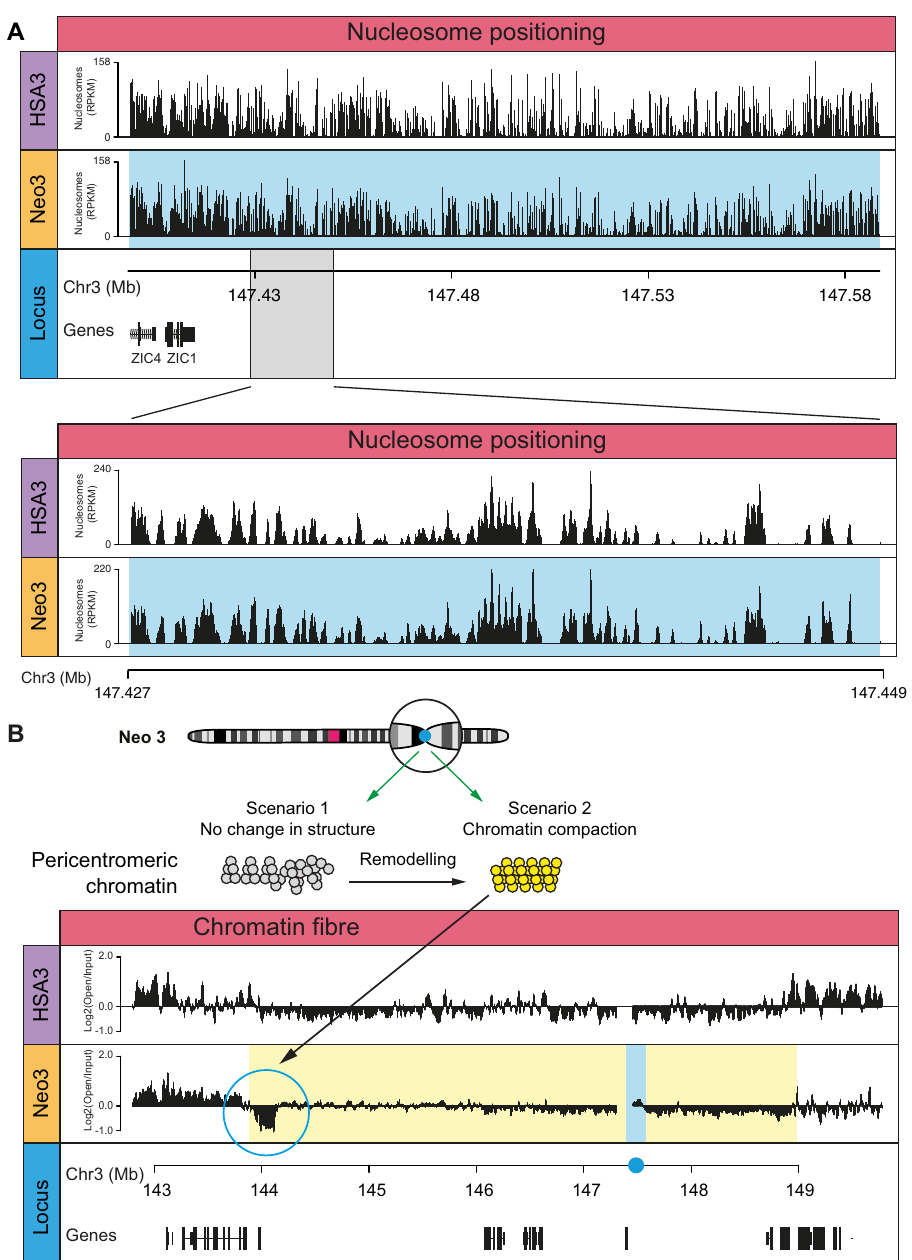
Fig. 5 | Compact heterochromatin in pericentromeric domain. A Nucleosome dyad coverage on the HSA3 and Neo3 chromosome atthe neocentromere domain (blue) with enlarged 22 Kb region (below). B Top, diagram showing potential sce- narios for chromatin remodelling at pericentromere after centromerisation. Bot- tom,DNAcorresponding to ‘ open ’ ordisrupted chromatin was isolated by sucrose gradient fractionation of chromatin followed by PFGE and used to map the